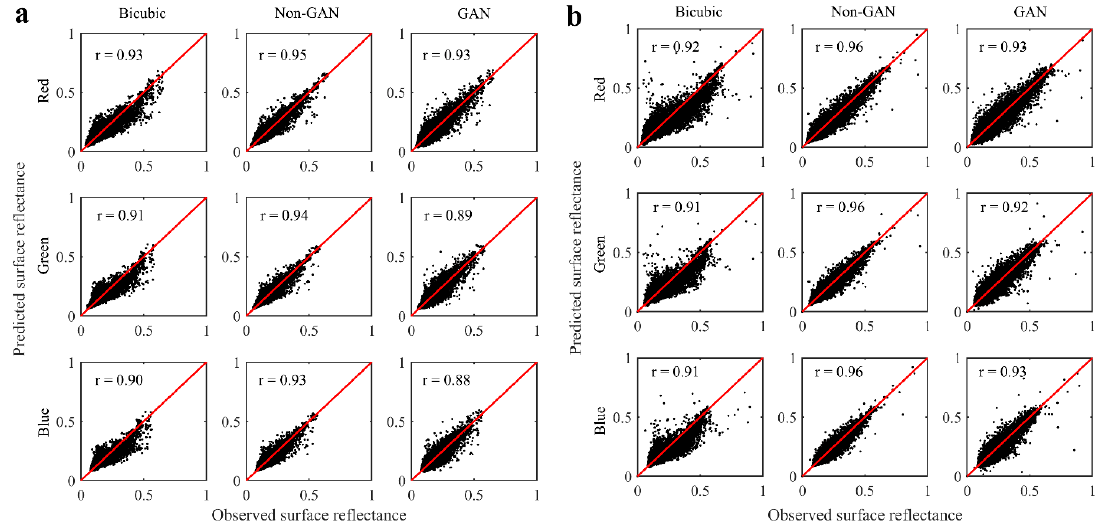
Figure 6. Scatterplots of the predicted vs. observed surface reflectance (Sentinel-2) from the bicubic interpolation, non- GAN-based super-resolution, and GAN-based super-resolution, in terms of red, green, and blue bands at site A ( a ) and site B ( b ), as shown in Figure 5.